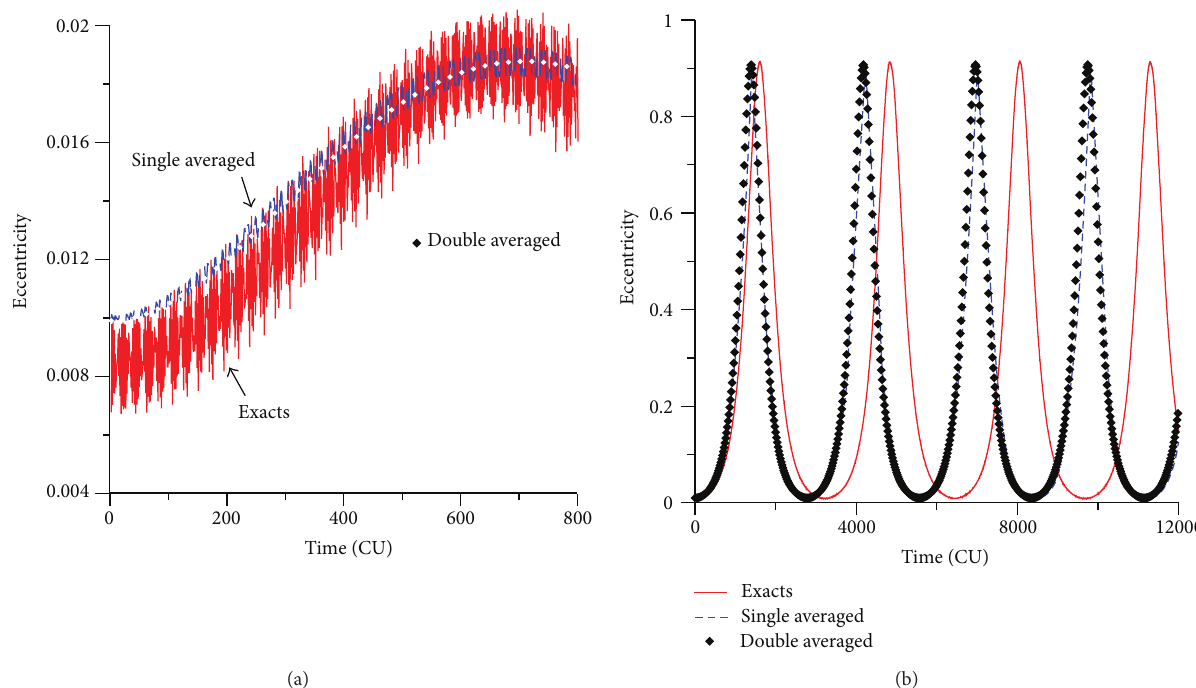
Figure 2: Evolution of the eccentricity for values of the inclination of 30 ∘ (a) and 70 ∘ (b). Initial conditions are a = 0.341 canonical units, e = 0.01, 𝜔 = 0, and Ω =